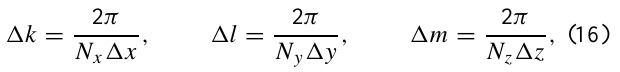
Table 1. Symbols and notation. u , v , w zonal, meridional, and vertical velocities θ , T , p , ρ potential temperature, temperature, pressure and density N , H buoyancy frequency, density scale height F z ( x ) vertical body force F 0 amplitude of vertical body force g(z) vertical distribution of the vertical body force F (t) temporal evolution of body force σ t total force duration ˆ a forcing frequency 2 πn/σ t n number of cycles in forcing k , l , m zonal, meridional, and vertical GW wavenumbers ω , τ = 2 π/ω wave frequency and period (Boussinesq) φ FL FL wave phase S sin ωt + sin ω(σ t − t) cos ωt − cos ω(σ t − t) e u , e v , e F z , ... Fourier transform of u , v , F z , ... e u GW , e v GW , ... The GW portion of the solution, e u , e v , ..., after the force is finished φ phase of wave in ray trace model (x 0 ,y 0 ,z 0 ) center of the convective plume envelope σ x , σ y , σ z half widths at half-max of the vertical body force in x , y , and z D = 4 . 5 σ x , D z = 4 . 5 σ z full widths and depths of the body force w pl updraft velocity of the convective plume envelope tropopause